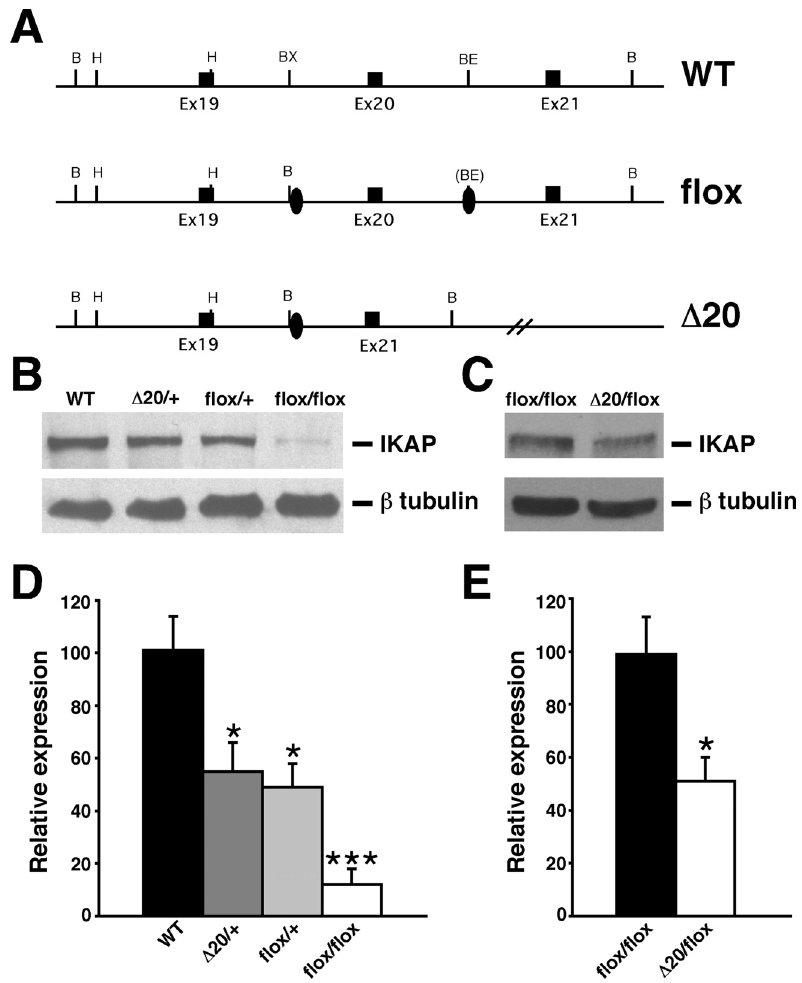
Figure 3 - Generation and molecular characterization of FD mouse models. (A) Schematic representation of wild-type allele (WT), Ikbkap flox allele (flox), and Ikbkap allele lacking exon 20 ( (cid:4) 20). Exons are represented by black rectangles, and black ovals represent the loxP sites. Restriction sites shown on the schematic are: Bam HI (B), HindIII (H), BstXI (BX) and BstEII (BE). (B) Western blot analyses of total protein lysates from forebrain of 11-month-old WT, Ikbkap (cid:4) 20/+ , Ikbkap flox/+ , and Ikbkap flox/flox mice. Upper panel shows detection of IKAP with the polyclonal anti-IKAP antibody (AnaSpec), and lower panel shows anti- (cid:5) -tubulin staining for loading control. Note that IKAP protein level is severely reduced in Ikbkap flox/flox brain. (C) Western blot analyses of total protein lysates from whole brain of E16.5 Ikbkap flox/flox and Ikbkap (cid:4) 20/flox embryos. Upper panel shows detection of IKAP with the polyclonal anti-IKAP antibody (AnaSpec), and lower panel shows anti- (cid:5) -tubulin staining for loading control. Note that in Ikbkap (cid:4) 20/flox brain IKAP protein expression is reduced compared to Ikbkap flox/flox brain. (D and E) Quantitative analyses of IKAP expression levels in mouse brains of differ- ent genotypes. (D) IKAP expression levels were normalized over tubulin levels and are expressed as percentage of WT. (E) IKAP expression levels were normalized over tubulin levels and are expressed as percentage of Ikbkap flox/flox . Data are represented as Mean (cid:6) SD; n = 3 experiments. *P < 0.05, ***P < 0.001. From Dietrich et al. (2012), by permission of Oxford University